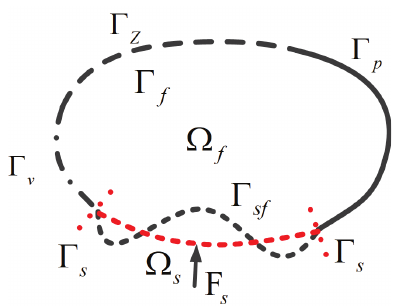
Figure 1. The interior vibro-acoustic coupling